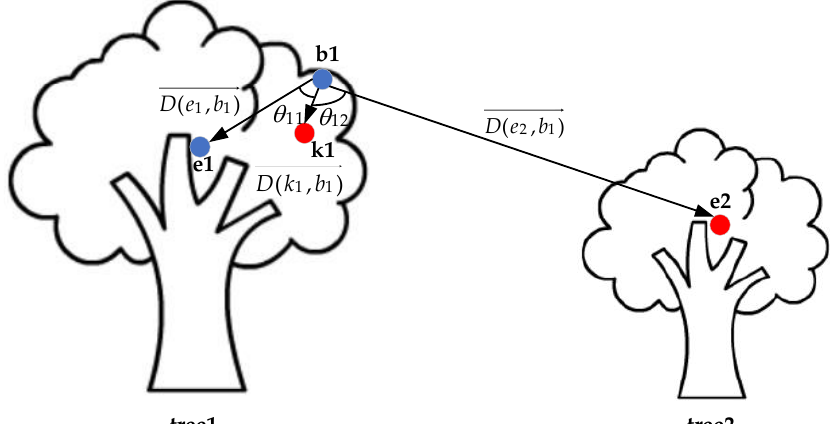
Figure 5. Crown boundary point segmentation.